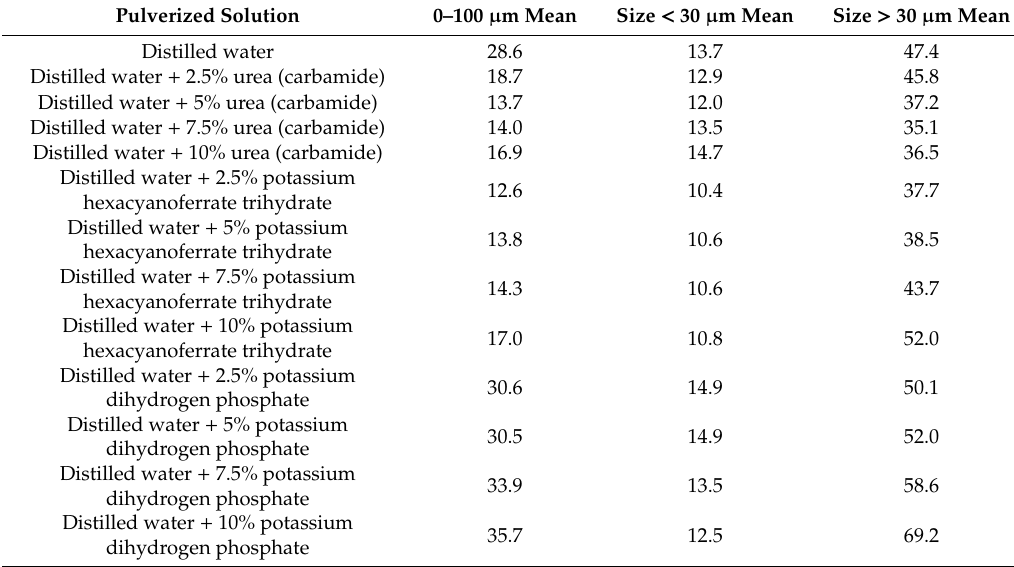
Table 1. Summarized results for the average diameters of fog droplets of the pulverized